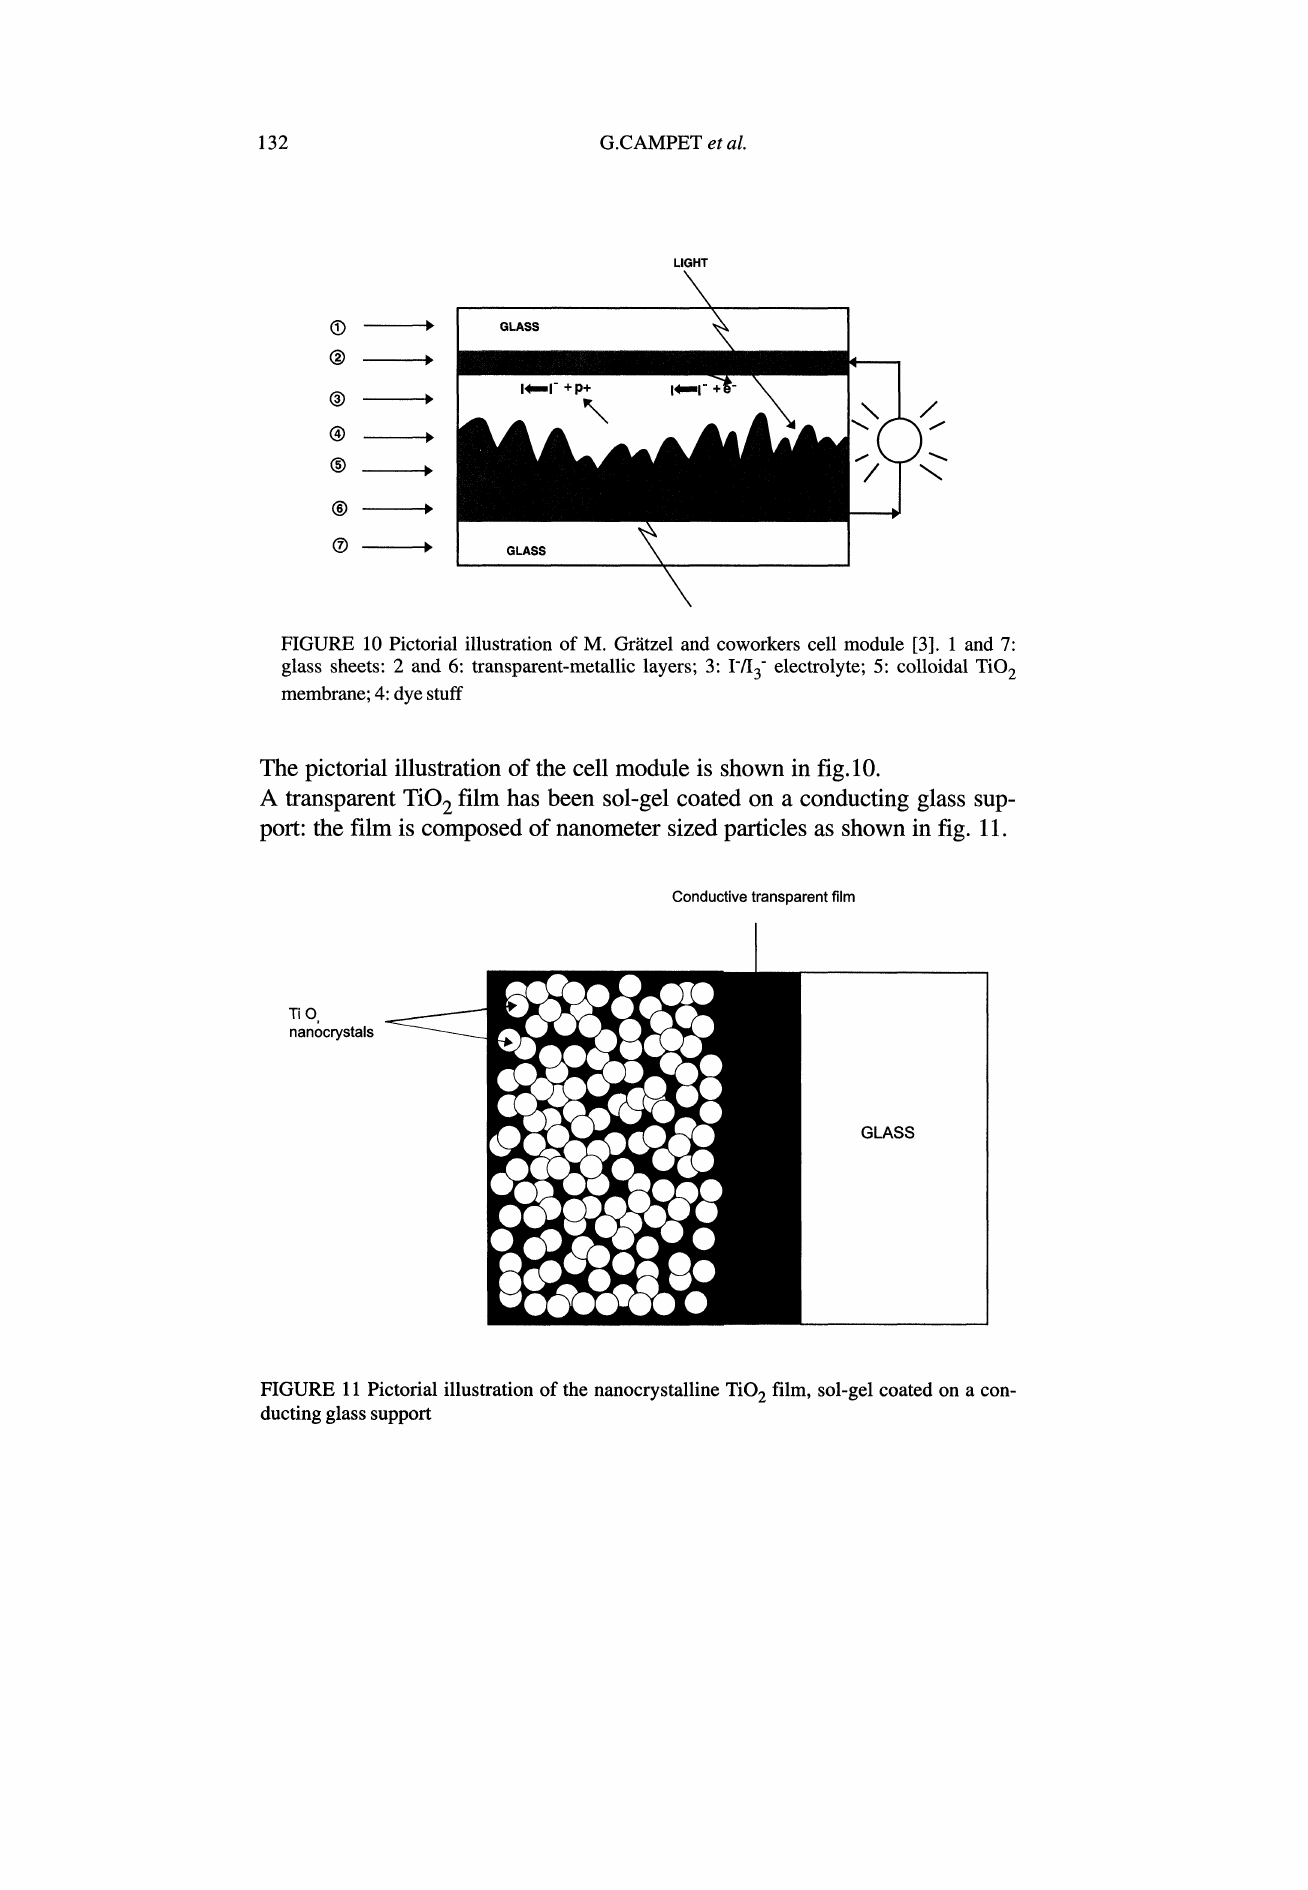
sol-gel coated on a con- 2 film,